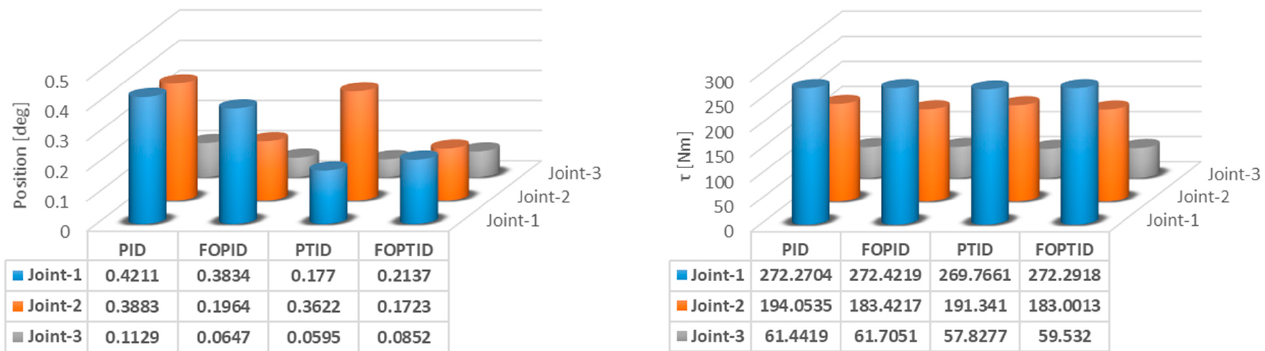
Figure 13. Joint position MAE values and control signal RMS values.